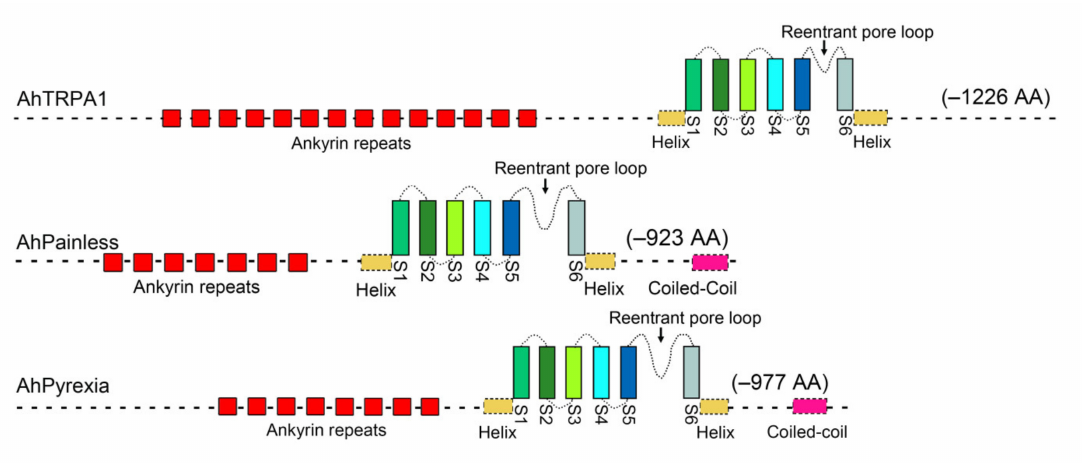
Figure 1. Predicted structural domains of TRPA channels. AhTRPA1, AhPainless, and AhPyrexia were three TRPA channels of Agasicles hygrophila , all of which have six transmembrane damains (S1–S6), and a reentrant pore loop between transmembrane domains S5 and